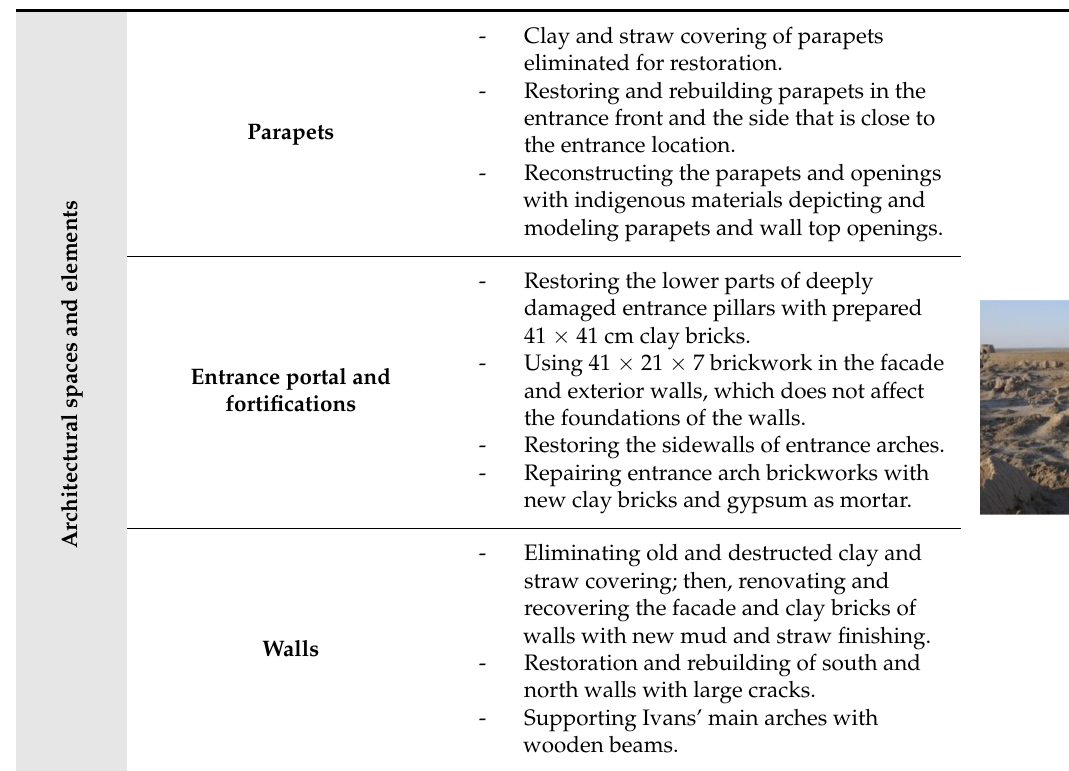
Table 5. Conservation plan for physical spaces (Mochi